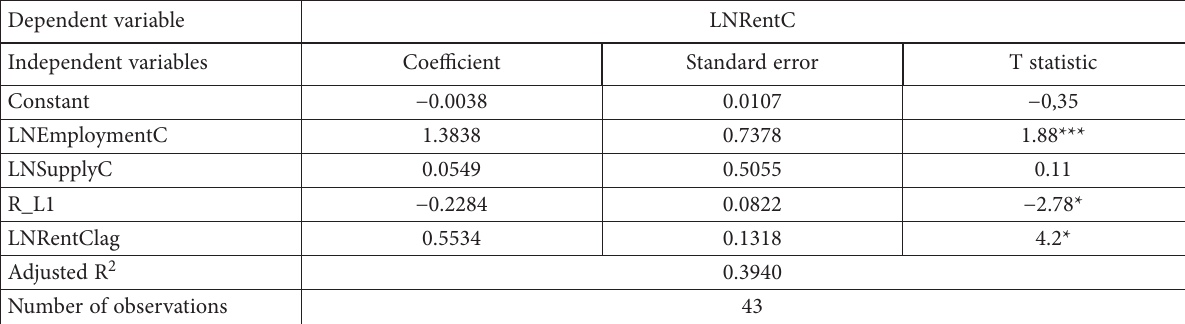
Table 4. The short-term equation in the symmetric model (source: own